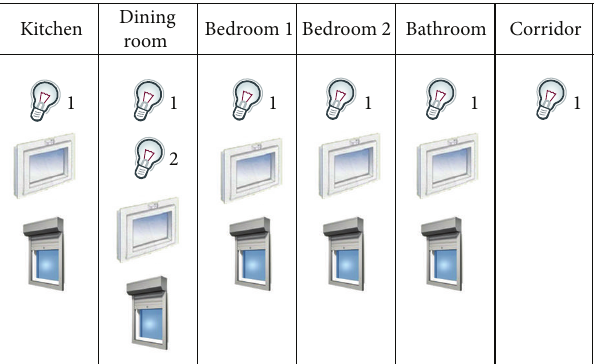
Figure 3: Home automation architecture assumed in the exper- imental development: one floor, several rooms (kitchen, dining room, bedrooms, bathroom, and corridor) equipped with different devices (lamps, windows, and shutters).